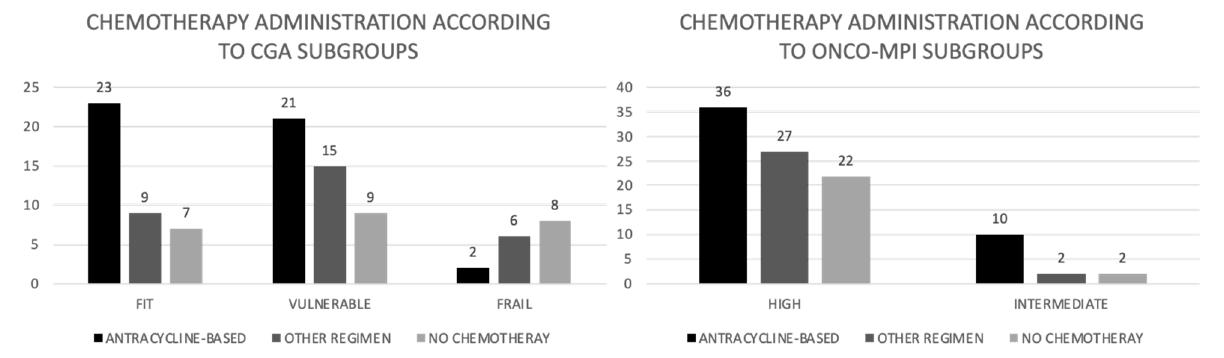
Figure 2. Chemotherapy administration according to CGA and onco-MPI subgroups (absolute numbers).